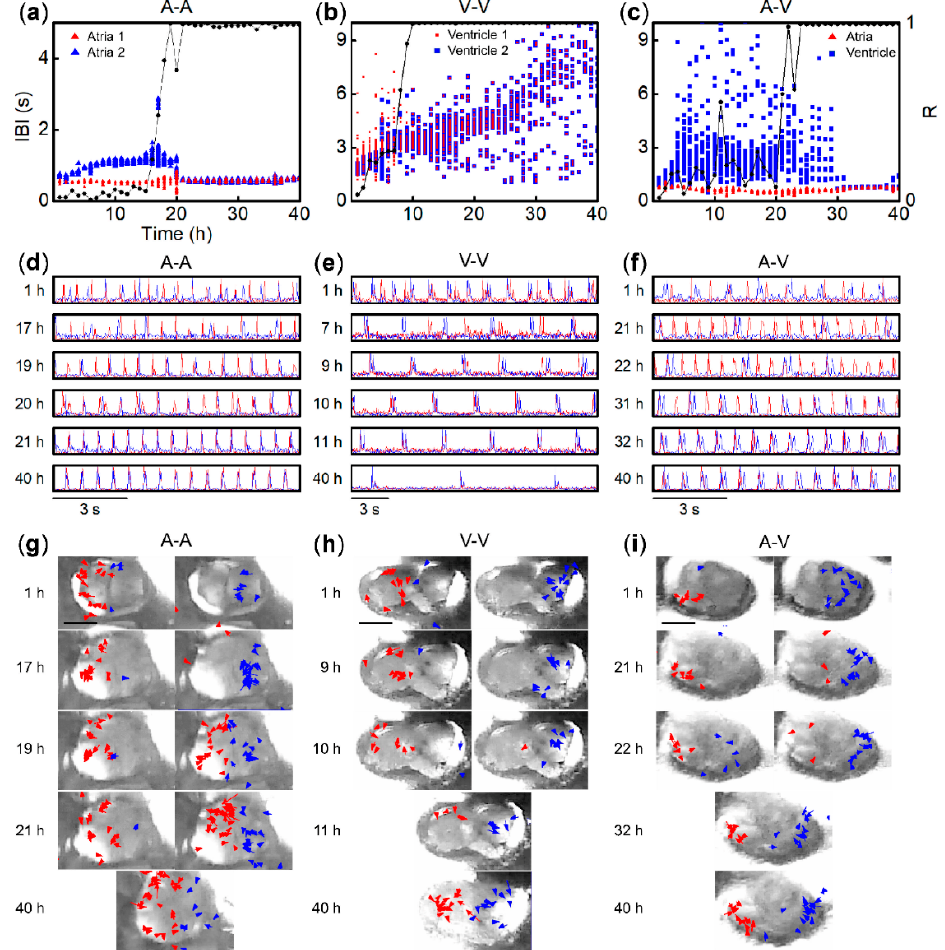
Figure 2. Beat activity of representative tissue fragments of atrium–atrium (A–A), ventricle–ventricle (V–V), and atrium–ventricle (A–V) pairs. ( a – c ) Time series of IBI for A–A, V–V, and A–V pairs, respectively. Triangles and squares indicate atrial and ventricular fragments. Red marks indicate fragments showing faster IBI at t = 1 h than other fragments, in blue. Line plots exhibit R values estimated by the Karamoto model as an index for synchronization. ( d – f ) Beat sequences at selected hours from (a–c), respectively. A beat reveals a single pulse for atrial and double peaks for ventricular fragments. Line coloring follows from (a–c). ( g – i ) Contract velocity fields of A–A, V–V, and A–V pairs at selected hours as shown in (a–c), respectively. Overlaid arrows on microscopic images indicate contract velocity with magnitude over 0.4 m/s. Two images at the same hour indicate different